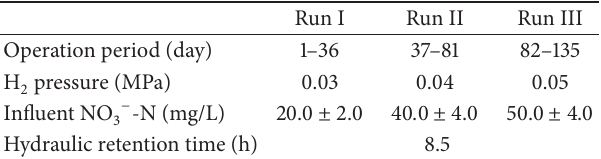
Table 2: Operation conditions of the membrane biofilm reactor.